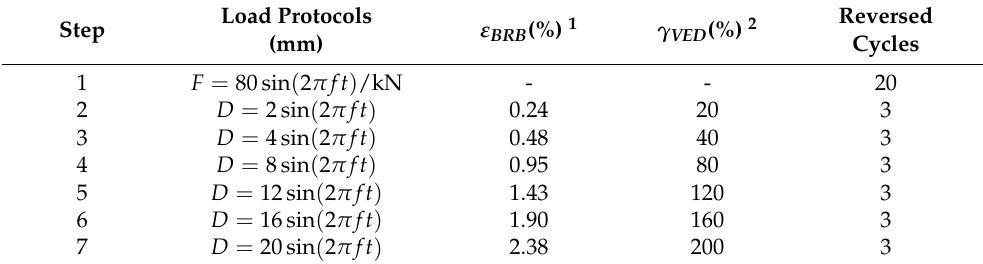
Table 3. Loading